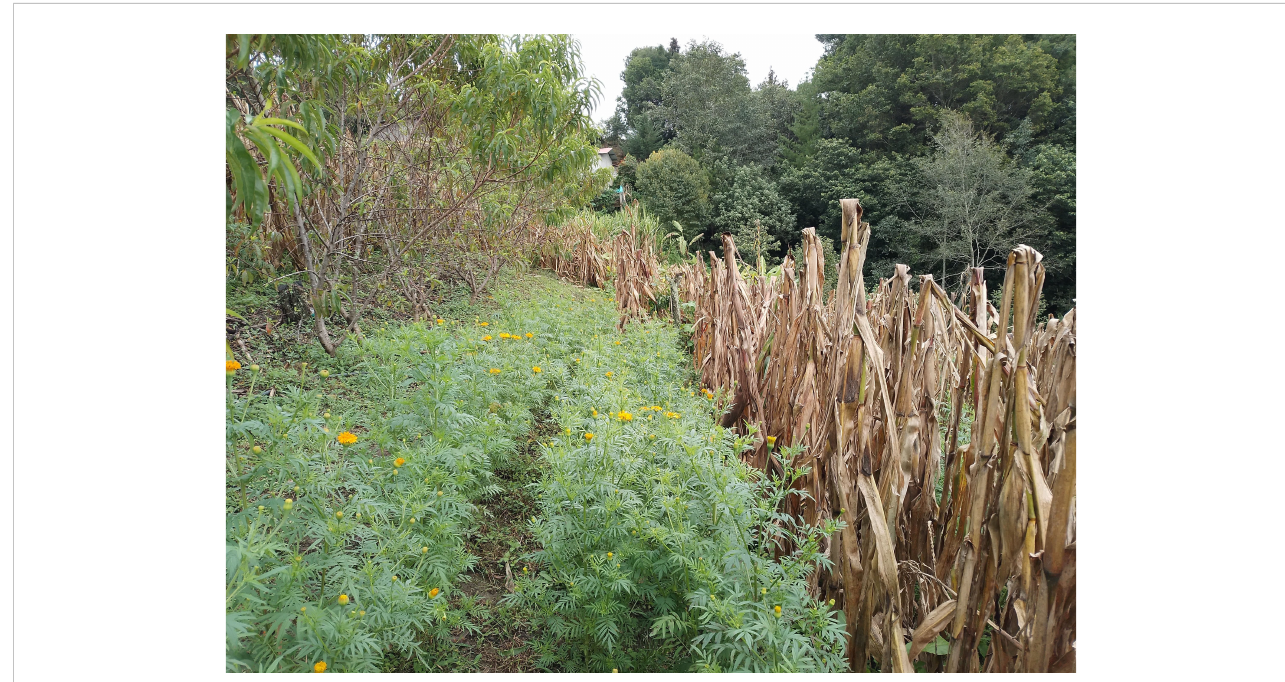
FIGURE 4 Strip cropping experiment in a Tzotzil milpa in Larrainzar, Chiapas. Beans ( Phaseolus vulgaris ) are followed by Marigolds ( Tagetes erecta ) and followed the next year by